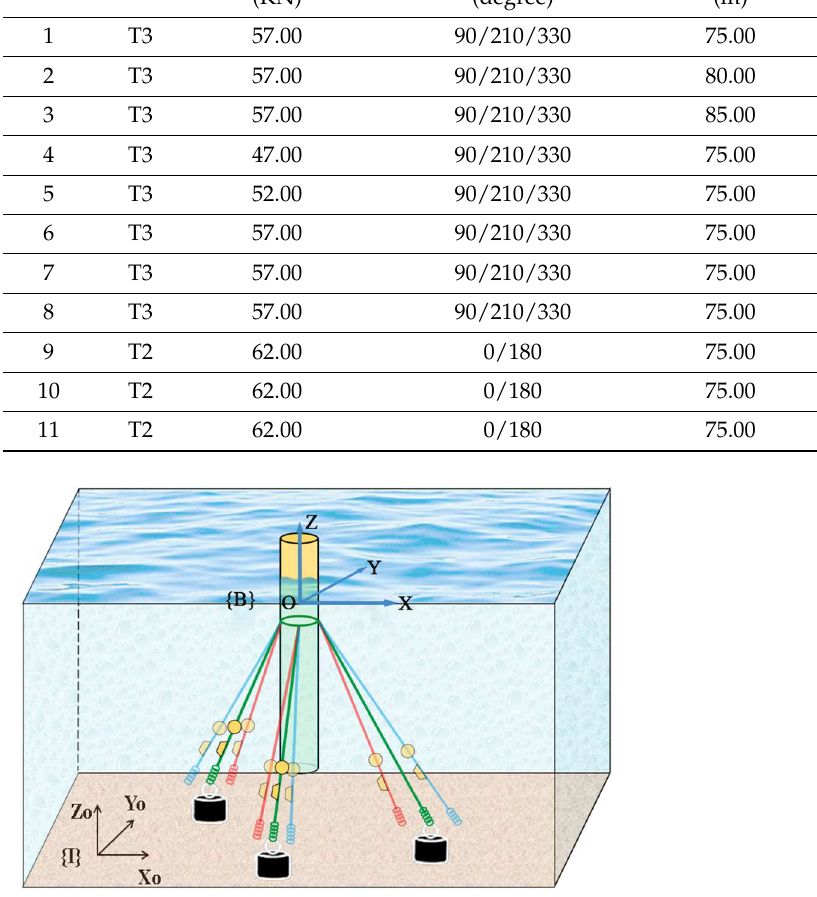
Figure 6. Mooring configuration with different lengths at L1 = 75 m, L2 = 80 m and L3 = 85 m.